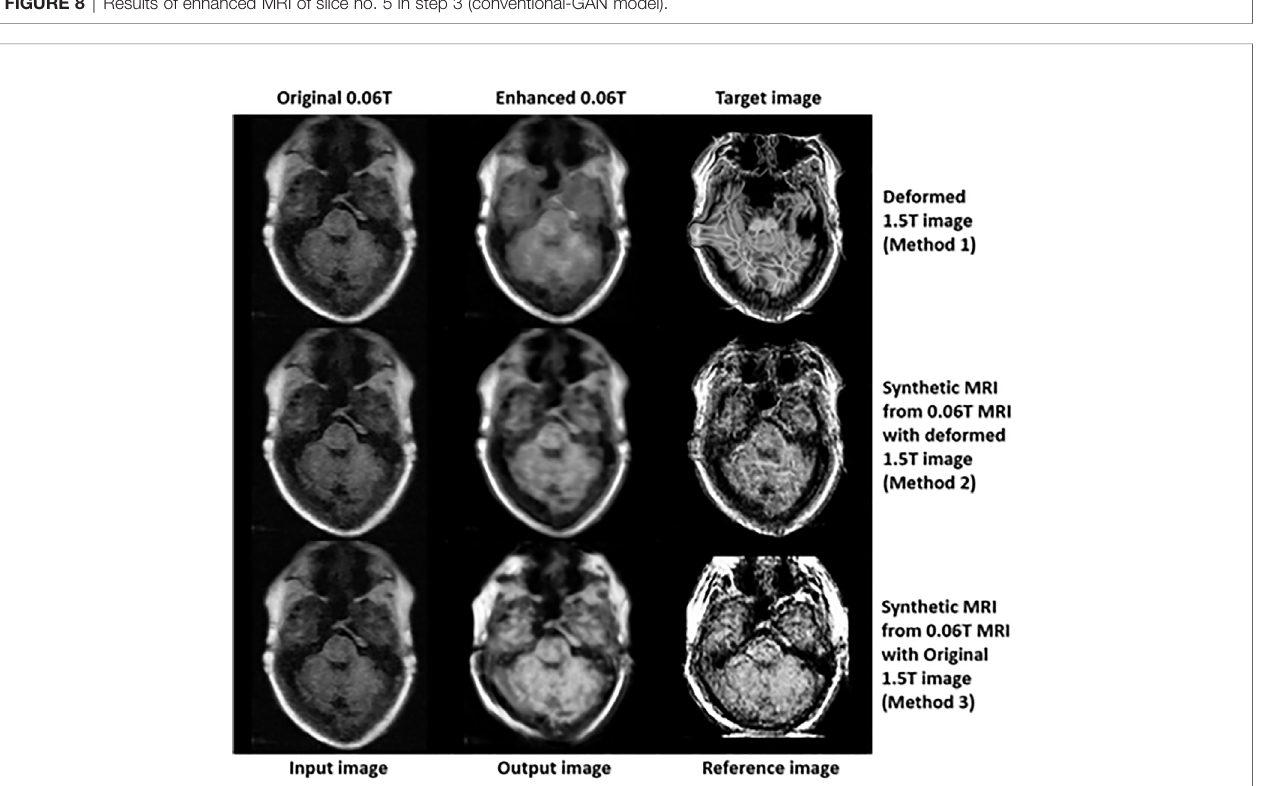
FIGURE 9 | Results of enhanced MRI of slice no. 8 in step 3 (conventional-GAN